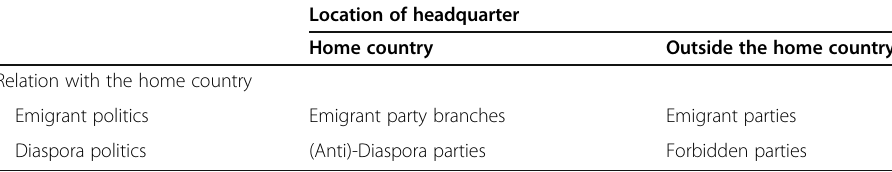
Table 1 A typology of parties